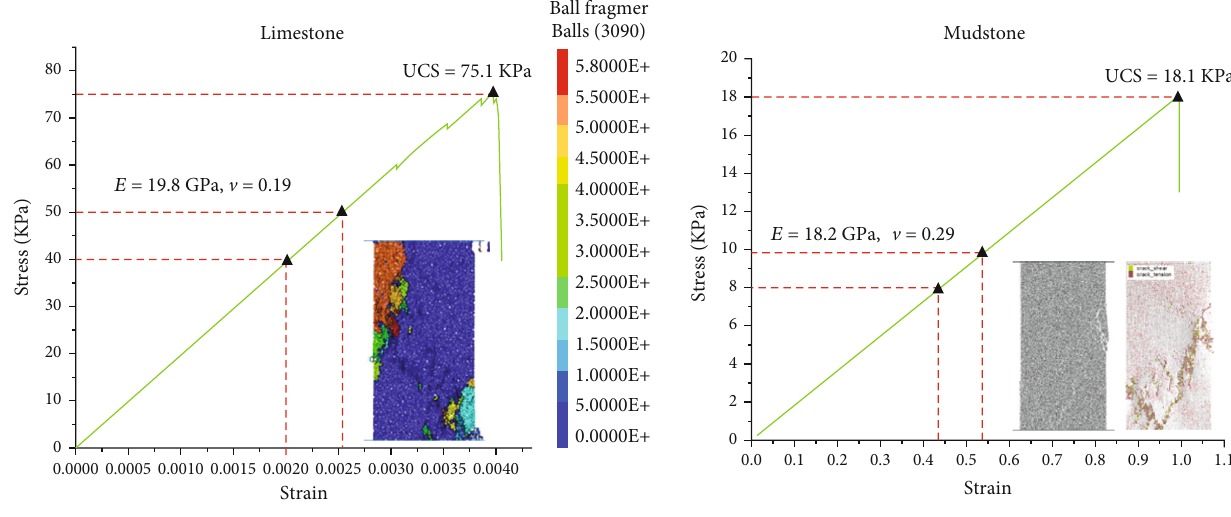
Figure 11: Calibration curve of limestone and mudstone parameters. Table 2: Rock and fracture plane microstrength parameters.